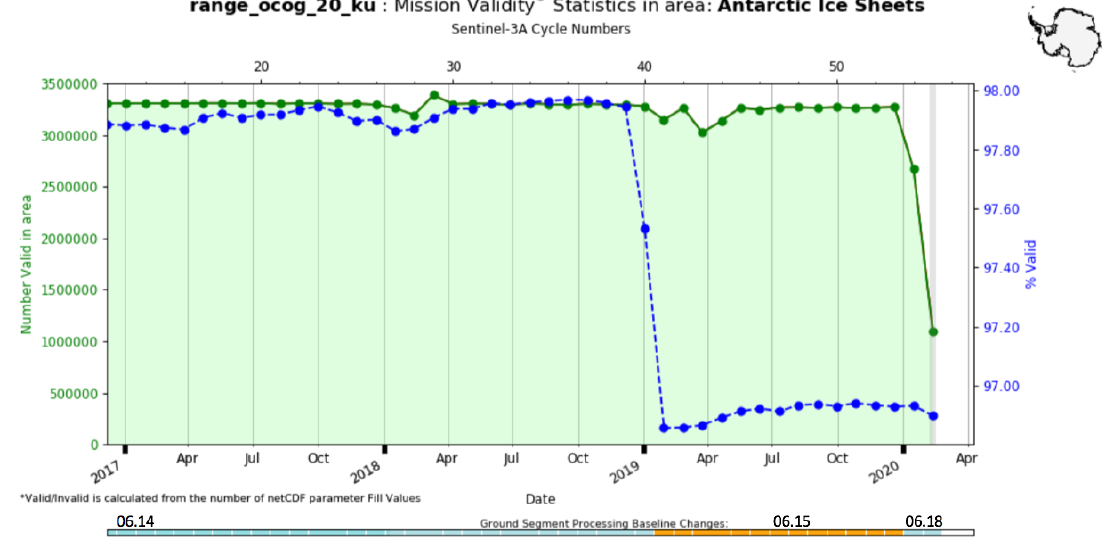
Figure 31. Time series of retracker failure for S3A over the Antarctic ice sheets. The coloured line at the bottom indicates changes in processing baseline from PB2.31 until cycle 40, then PB2.43